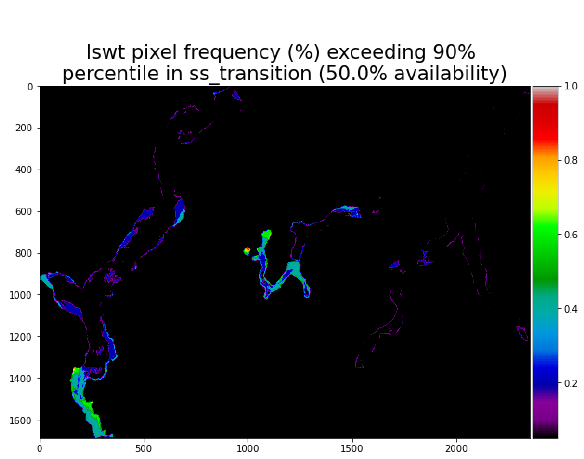
Figure 19. CHLOROPHYLL-A spatial pattern map in summer - autumn transition